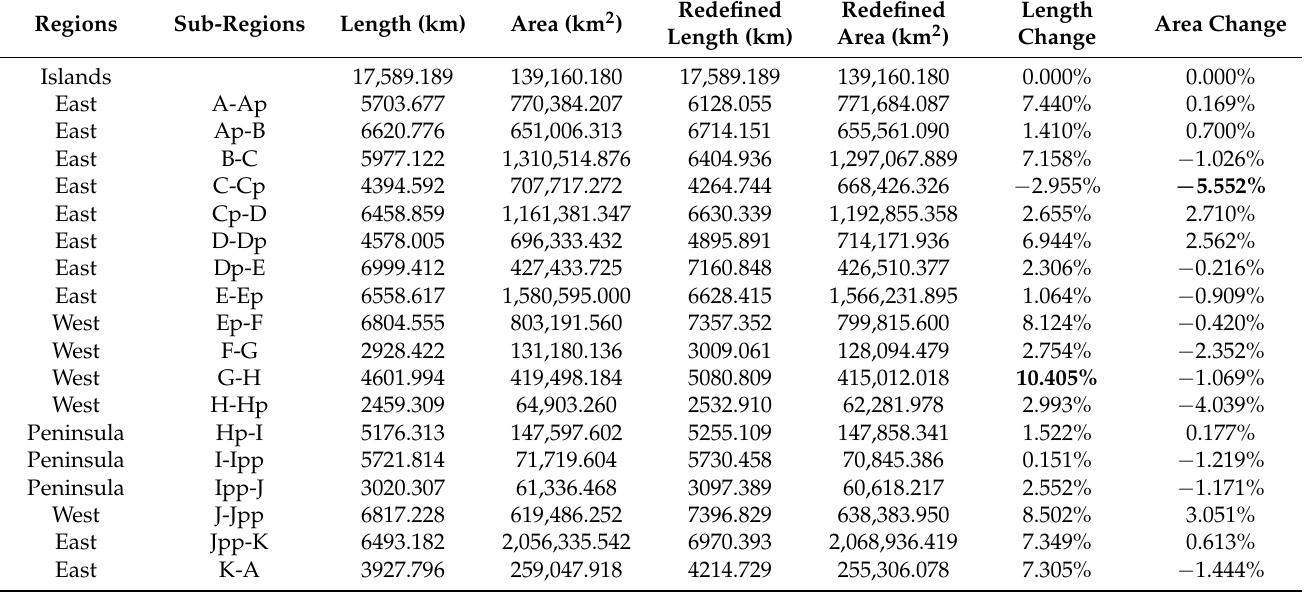
Figure 13. Antarctic ice flow line map. The ice flow lines belonging to different basins of the re-divided Antarctic basin system are rendered in different colors. Table 3. Original ice basins area and boundary lengths and changes in ice basins area and boundary lengths after redefinition with ice flow lines. The max absolute values in the corresponding column are marked in BOLD fonts.